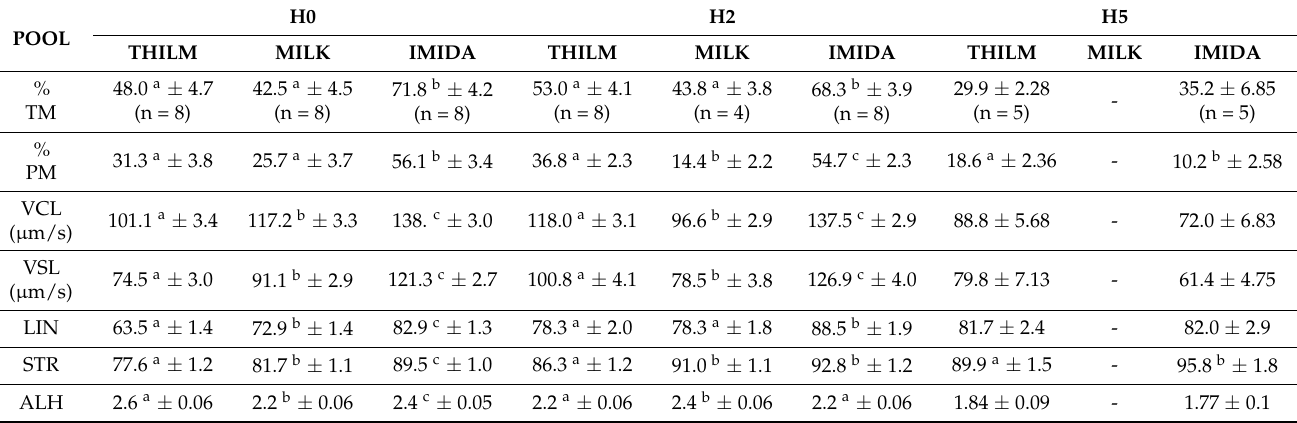
Table 5. Average semen parameters obtained by CASA system for the pool of MG goats in resistance test, according to extender (if there is no number: no motile spermatozoa reached that evaluation time with that